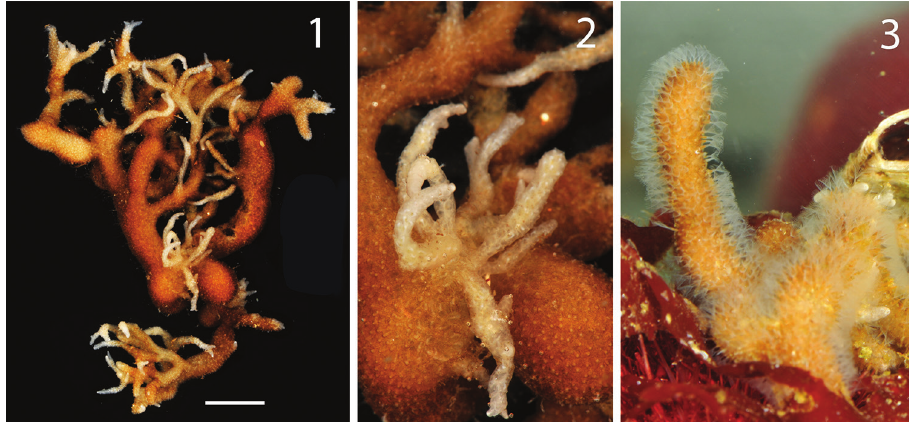
Figure 6. Alcyonidium sp. colony (MNA 2733) collected by SCUBA diving. Entire colony ( 1 ) and details ( 2 ) of the specimens after fixation in ethanol. Detail of the colony depicted in aquarium immediately after the collection ( 3